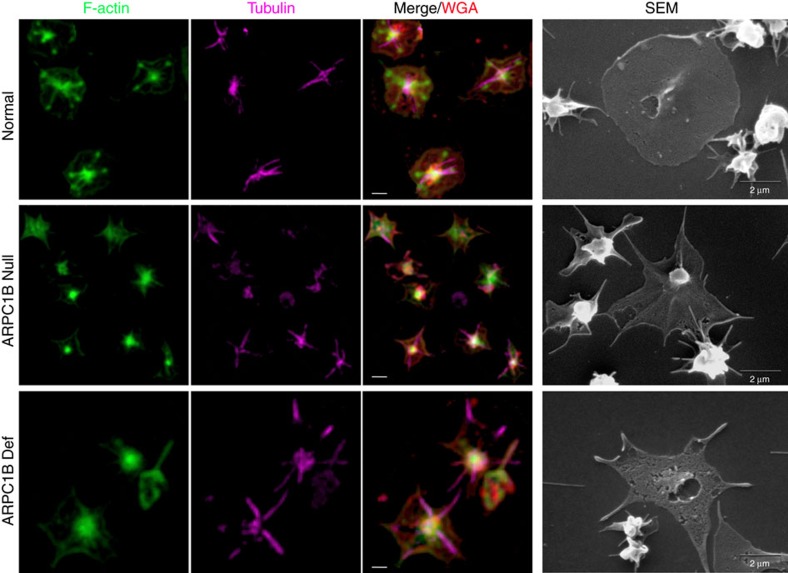
Abnormal spreading of ARPC1B-deficient platelets on fibrinogen.Washed platelets were allowed to spread on fibrinogen-treated coverslips for 45 min prior to fixation and imaging by SEM (right column; bars=2 μm), or by spinning disc laser fluorescence confocal microscopy (left columns; 3D renders of deconvolved z-series, bars=1 μm) after surface staining with wheat germ agglutinin (WGA; red), staining for F-actin with phalloidin (green) and immunostaining for alpha tubulin (magenta). Maximally spread platelets from a normal donor (top row) typically show fully formed lamellipodia with thin tubulin filaments and multiple F-actin filaments intersecting with podosome-like actin nodules. In contrast, maximally spread platelets from both ARPC1B-null (middle row) and ARPC1B-deficient (bottom row) patients tend to form spiky filopodial-lamellipodial structures lacking podosomes that sometimes show elongated actin filaments (see also Fig. 7).